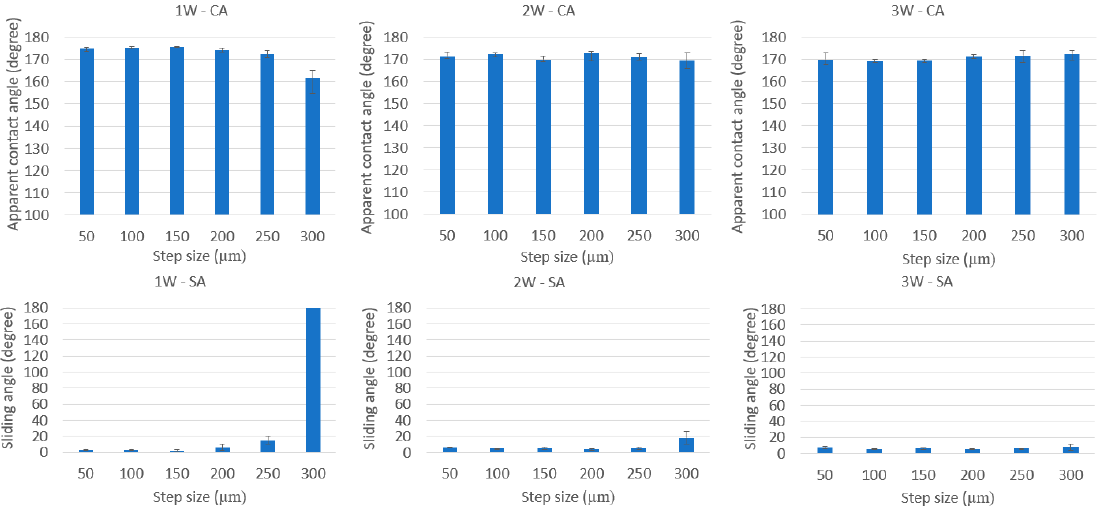
Figure 13. Apparent contact angle and sliding angle for the grid pattern 35 days after heat treatment.